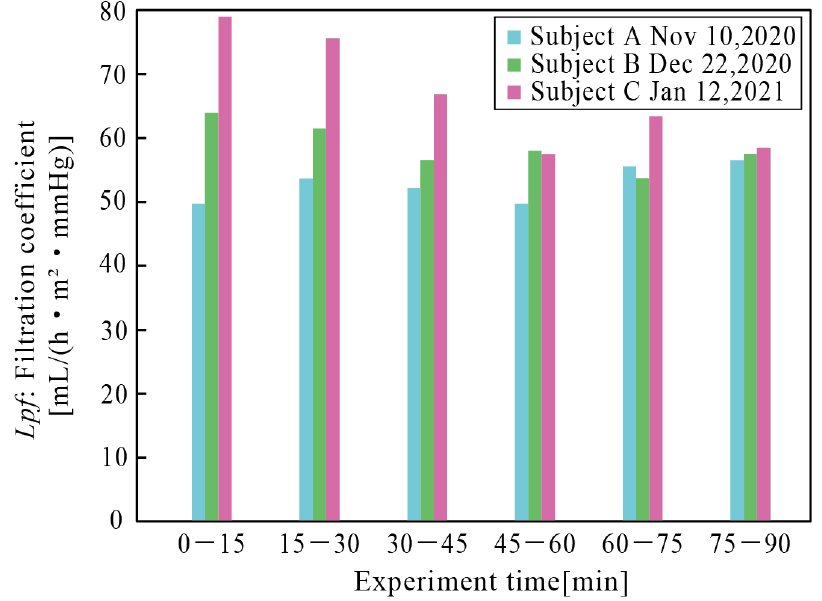
Figure 10. Filtration coefficients in the ex vivo experiments with respect to experiment time. Filtrate was collected every 15 min. No significant decreases or fluctuations were observed. Filtration coefficients are comparable to those from in vitro experiments with an albumin concentration of around 2 g/dL.